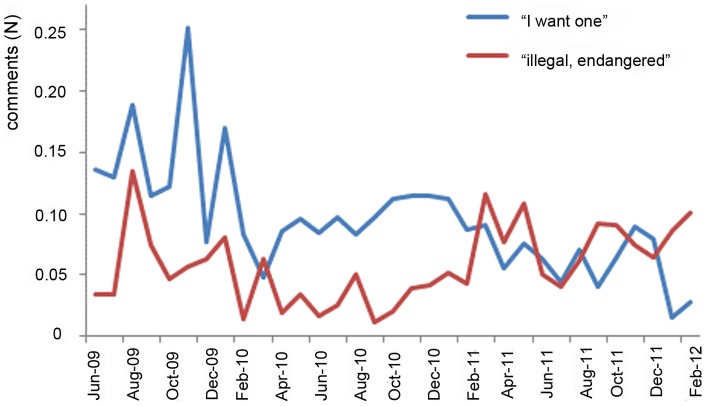
Comments on a viral YouTube video.Indicated is the monthly proportion of commentators that indicate that they wanted a slow loris as pet and those that indicted that it is illegal to keep slow lorises as a pet and/or that slow lorises are globally threatened. The proportion of commentators wanting a loris decreased significantly over time (Pearson's Product Moment Correlation, n = 33, R2 = 44.6%, p<0.0001). The proportion of commentators reporting the loris to be illegal/endangered did not increase significantly over time (Pearson's Product Moment Correlation, n = 33, R2 = 9.4%, p<0.08).